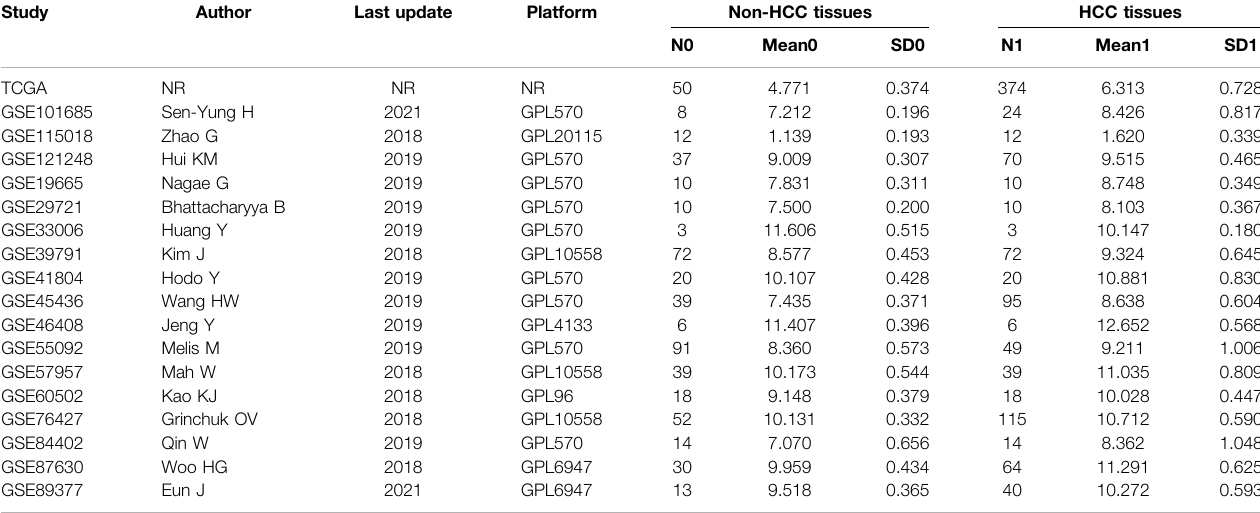
TABLE 1 | Characteristics of included